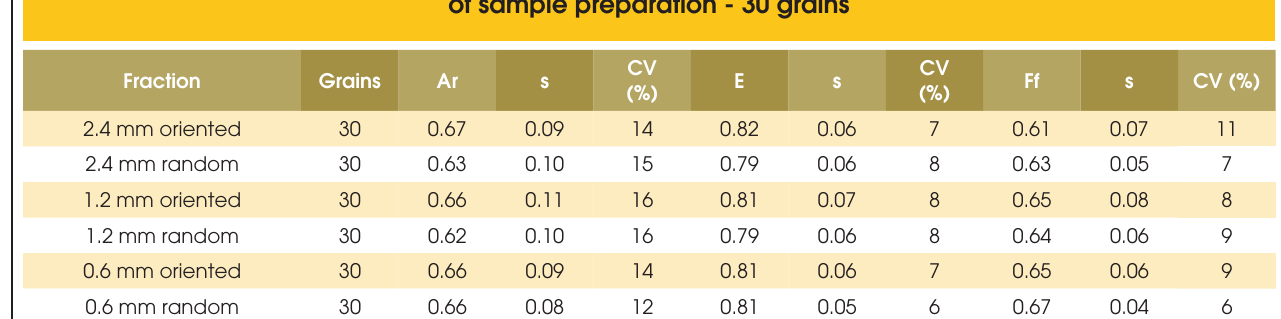
Table 1 – Forms factors calculated to evaluate the influence